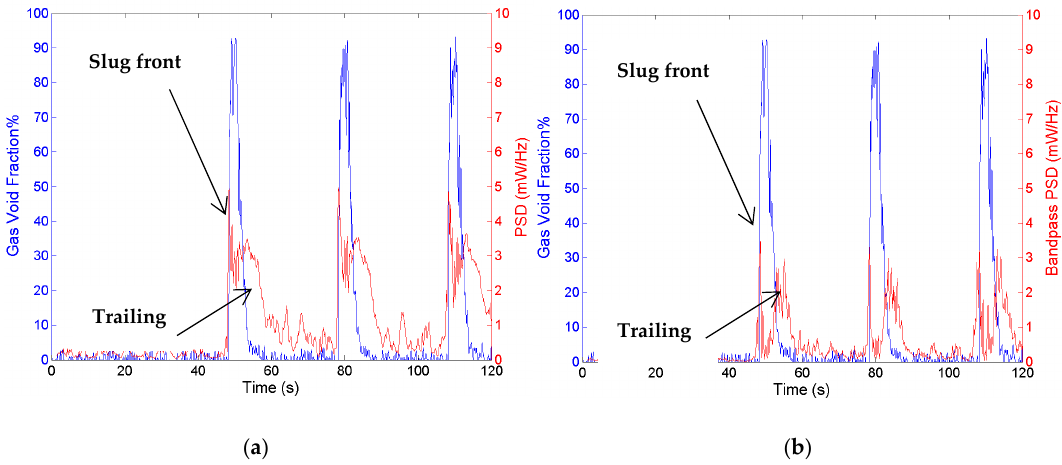
Figure 7. ( a ) Gas volume fraction (GVF) from gamma and power spectral density (PSD) of Doppler signal using STFT; ( b ) GVF from gamma and bandpass PSD 0.95–1.05 KHz.